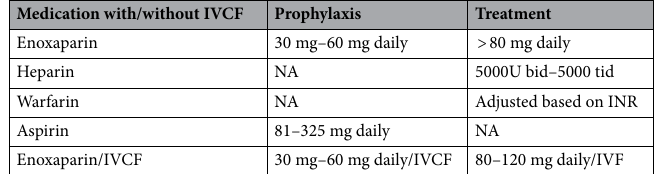
Table 2. VTE prophylaxis and therapeutic methods.